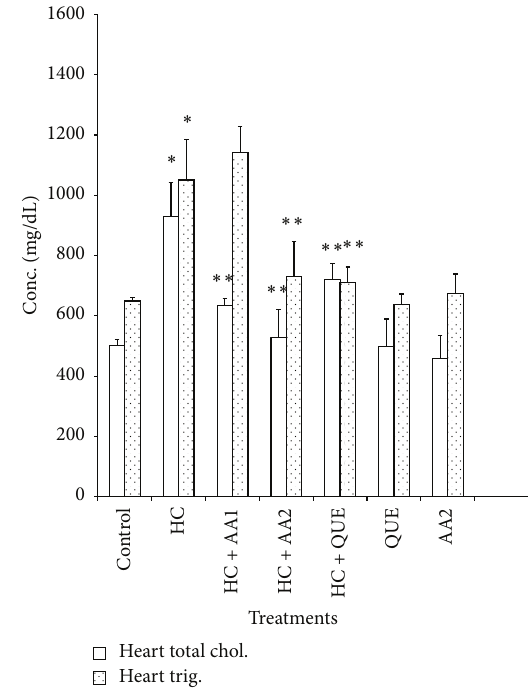
Figure 1: Effects of methanol extract of Artocarpus altilis and Questran on cardiac total cholesterol and triglyceride levels of hypercholesterolemic rats. ∗ Significantly different from control ( 𝑃 < 0.05 ), ∗∗ significantly different from HC ( 𝑃 < 0.05 ). HC: Hyper- cholesterolemic rats, AA1: Artocarpus altilis at 100 mg/kg, AA2: Artocarpus altilis at 200 mg/kg, and QUE: Questran at 0.26